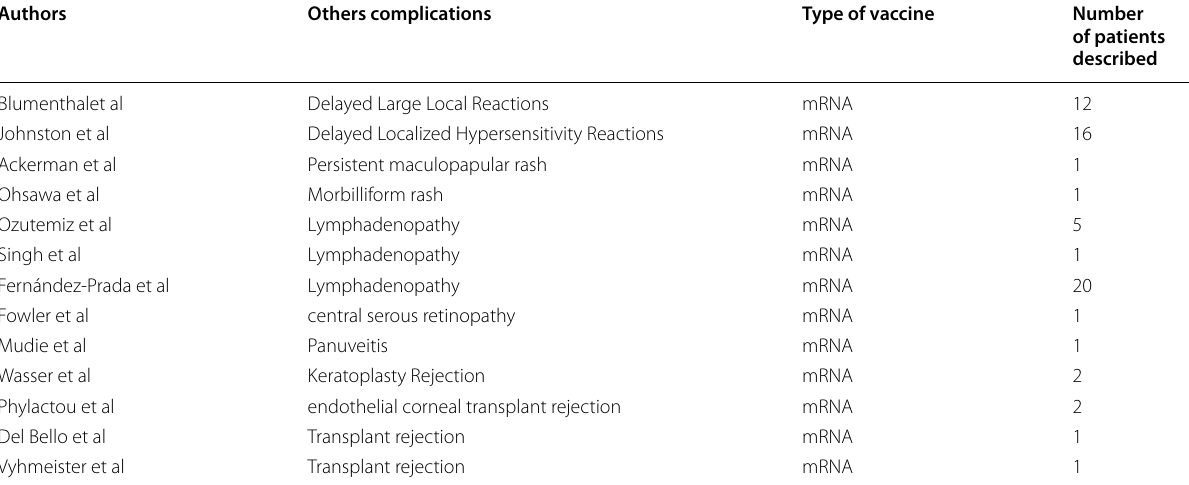
Table 5 Previous case-report about vaccine-related miscellaneous